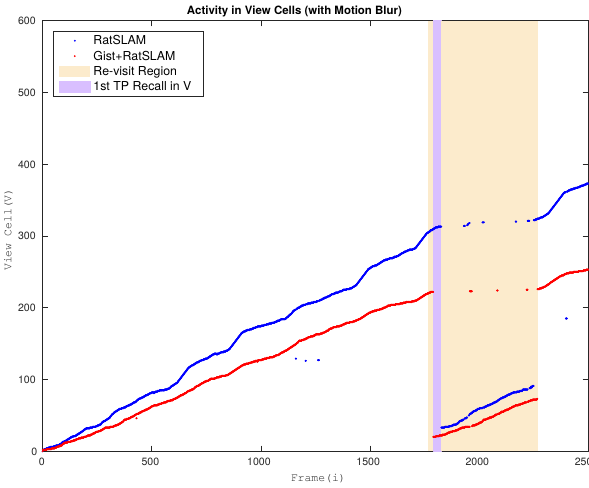
Figure 6: Applying motion blur to images oppo- site to the direction of rotation induces false posi- tive activity in the view cells for RatSLAM, whereas Gist+RatSLAM shows robustness against